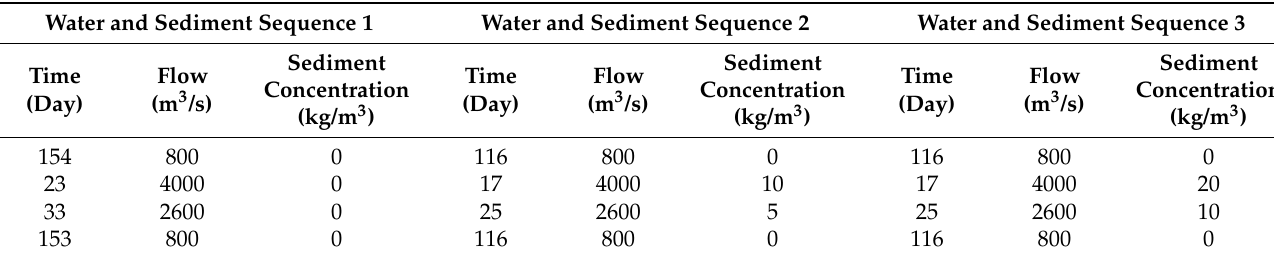
Table 1. Water and sediment levels in model tests under different engineering densities.